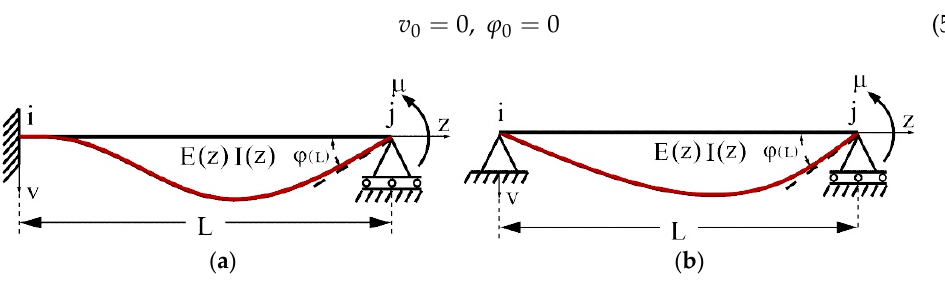
Figure 10. ( a ) The applied moment µ rotates the end j by an amount of ϕ ( L ) ; ( b ) the applied moment µ rotates the end j by an amount of ϕ ( L )